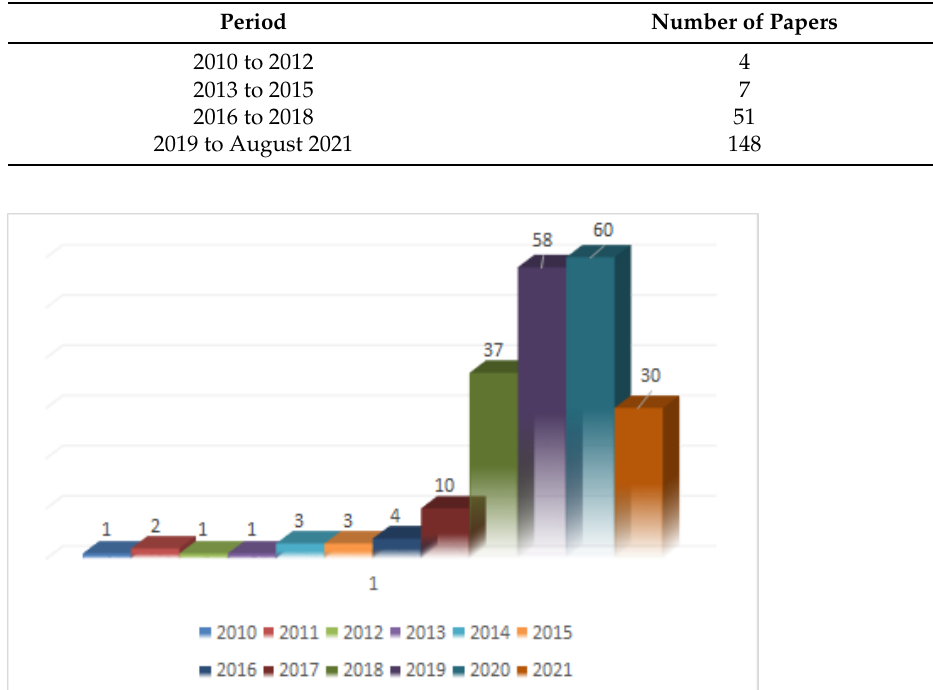
Table 2. Number of papers from 2010 to 2021.